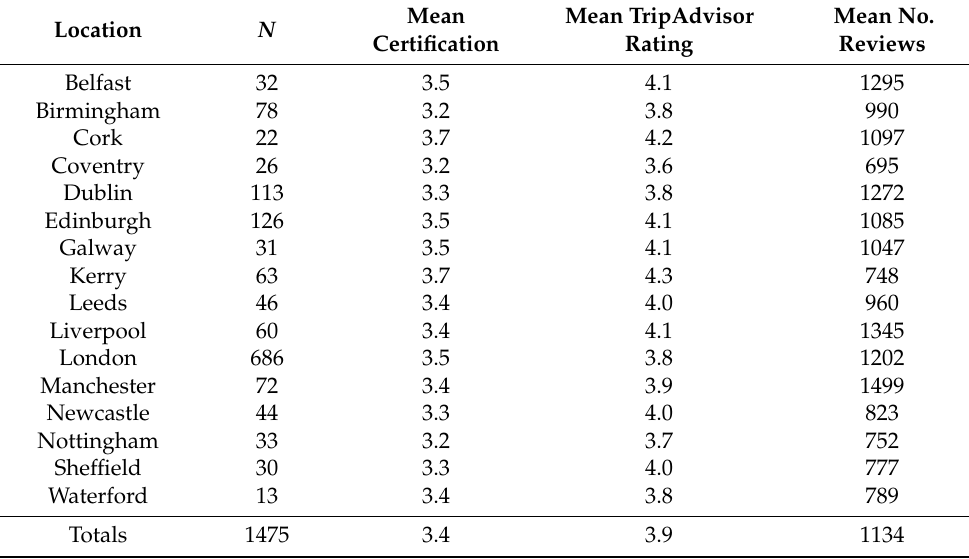
Table 1. Descriptive Statistics—Regional Dataset.